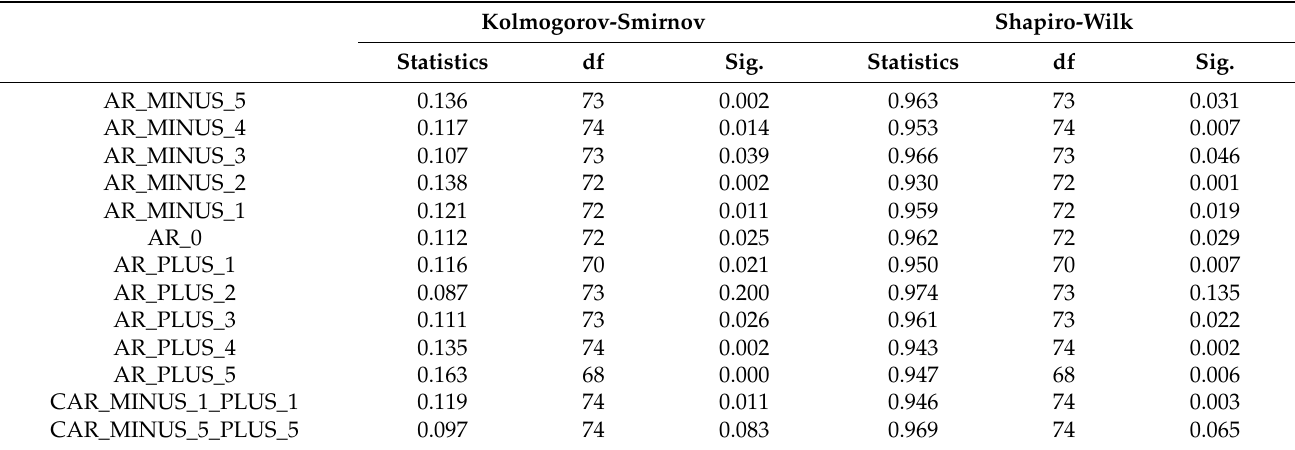
Table 3. Normality tests after deleting extreme